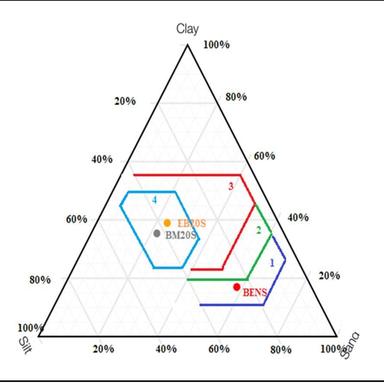
Projection of particle size distribution results on Winkler's diagram. (1) Solid bricks; (2) Vertically perforated bricks; (3) Roof tiles and lightweight blocks; (4) Hollow bricks.